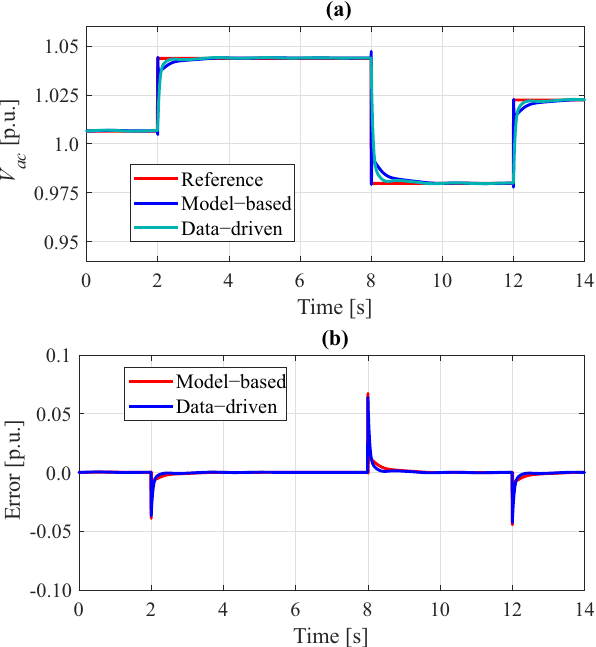
Figure 5. Reference changes: ( a ) voltage step comparison and ( b ) errors of differences.